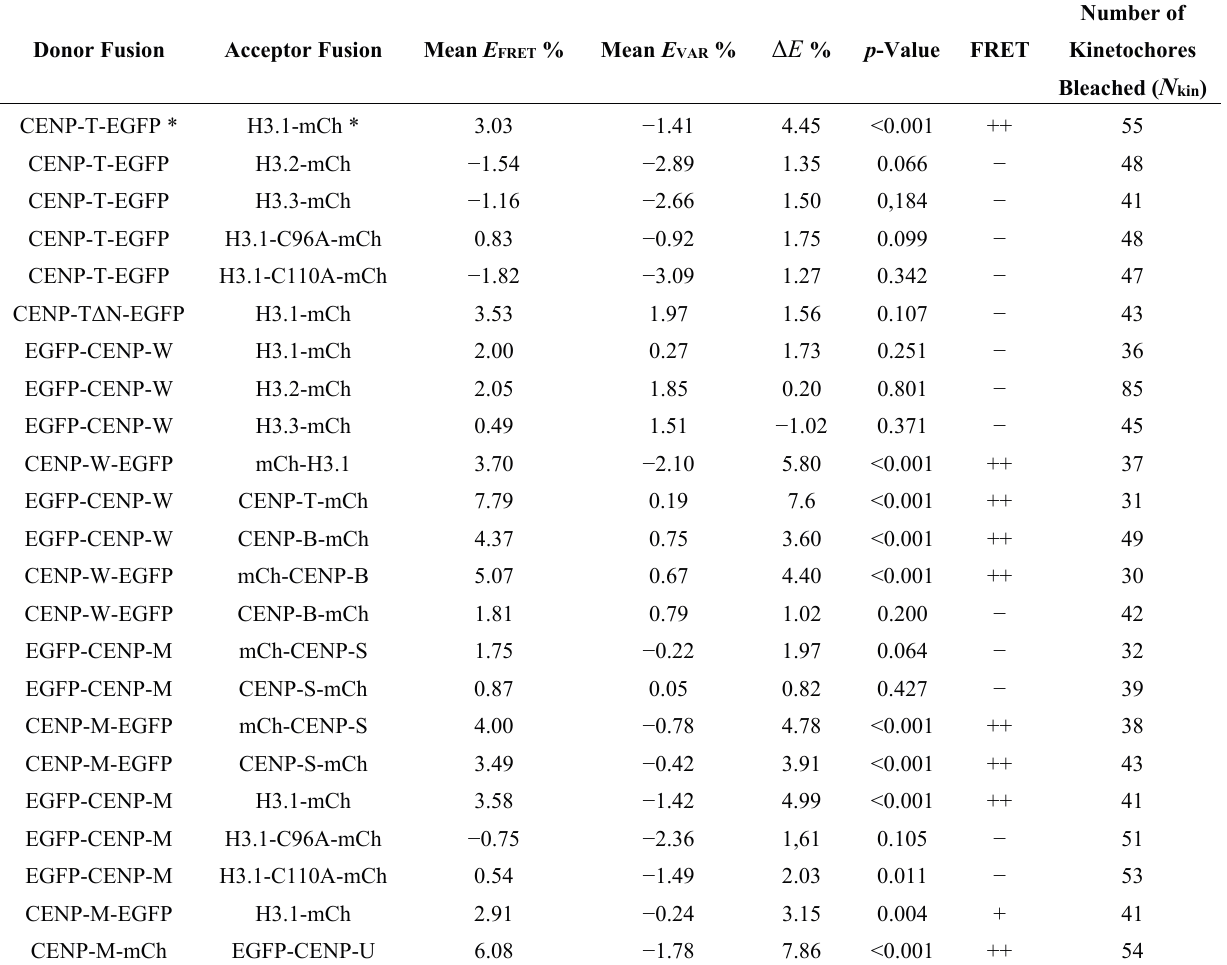
Table 1. Summary of FRET measurements in this study between CCAN proteins and